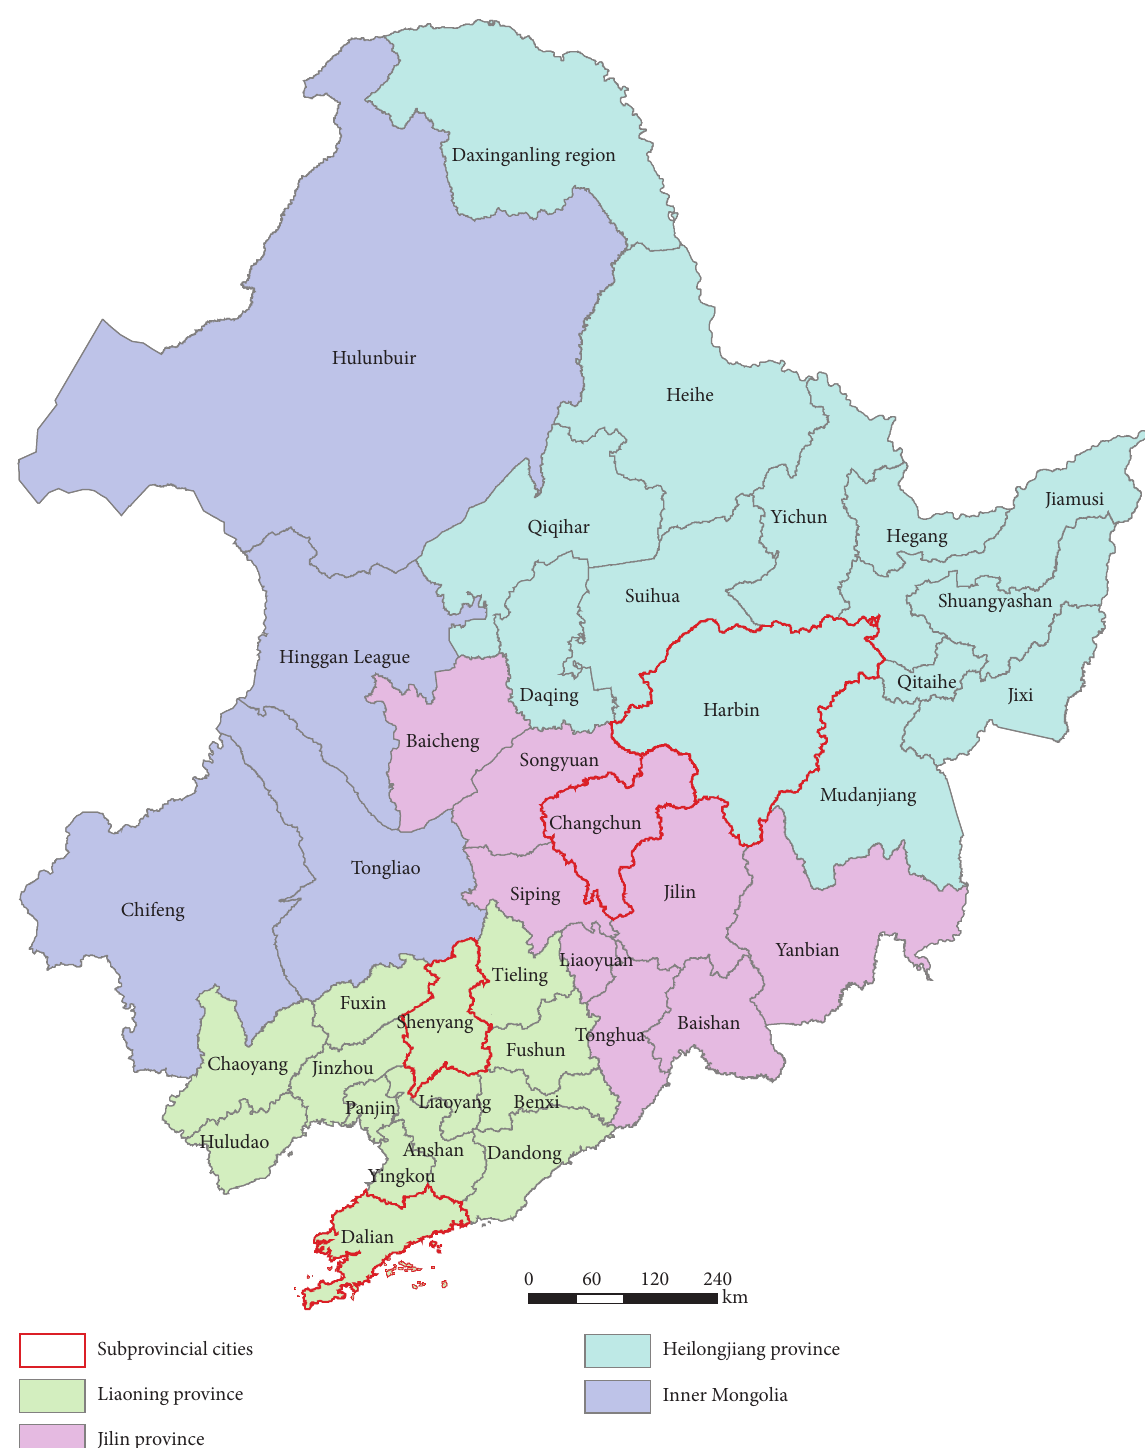
Figure 1: Schematic diagram of Northeast